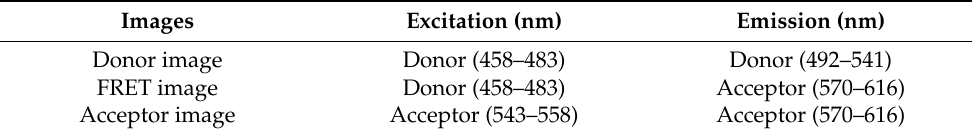
Table 2. Wavelengths of the microscope excitation and emission filters used in this study. Images Excitation (nm) Donor